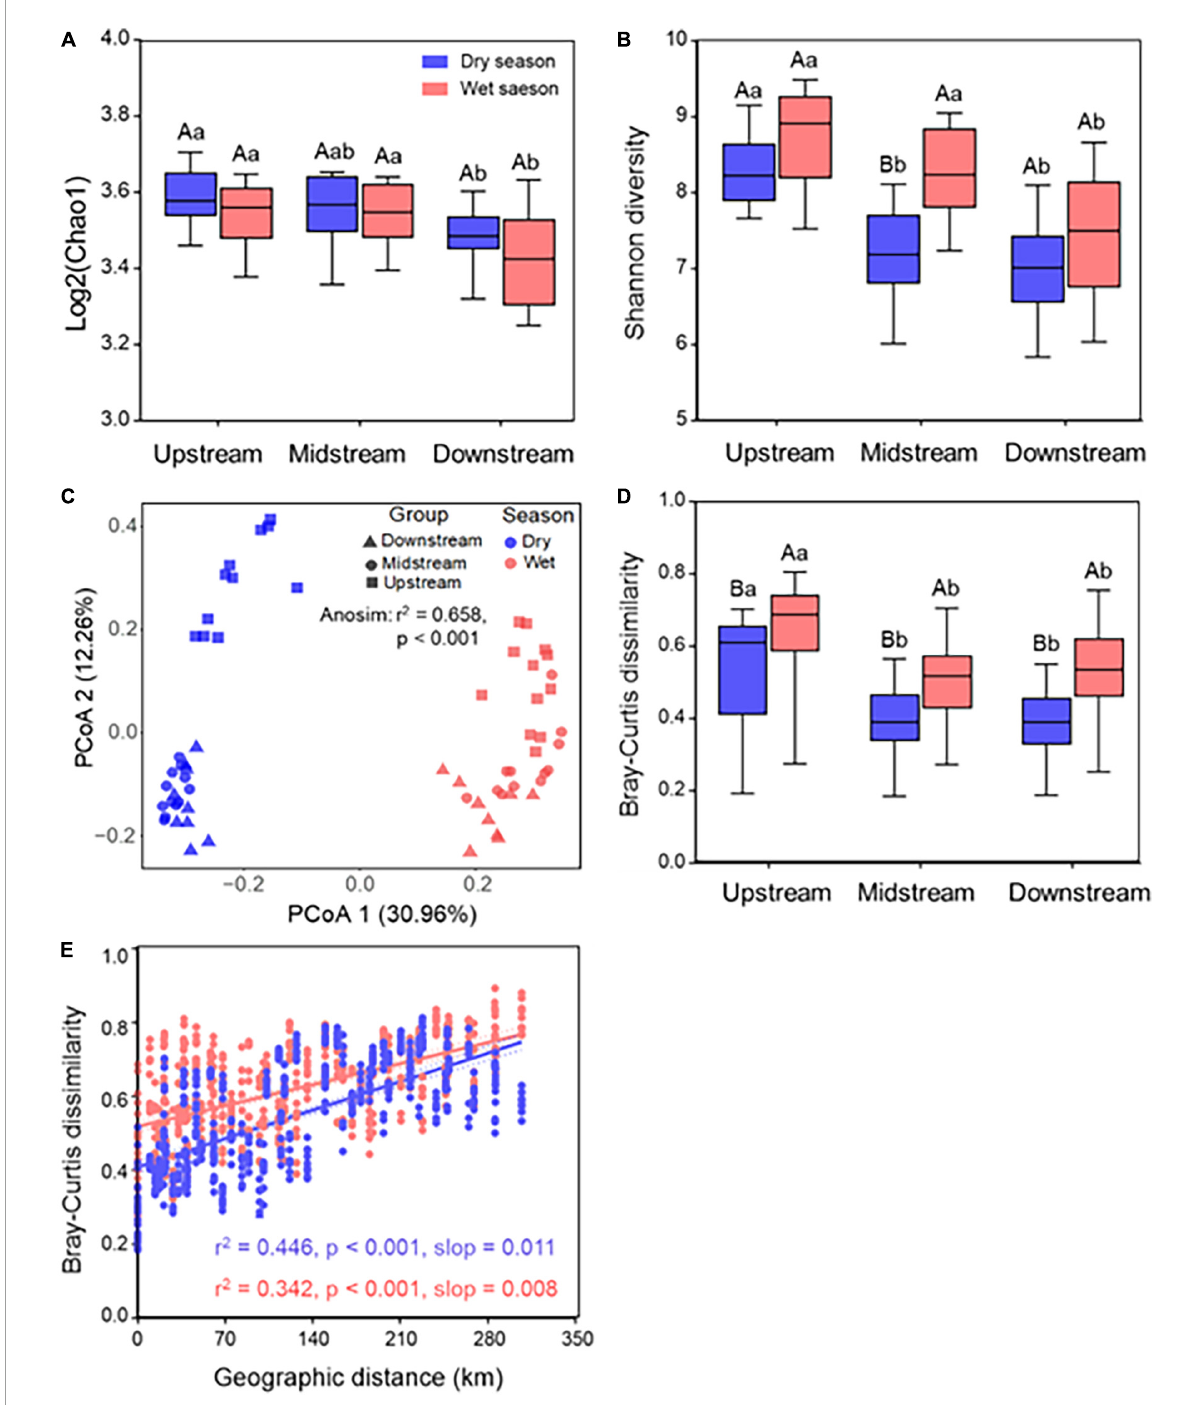
FIGURE1 Bacterial biodiversity and distance–decay pattern of the Chishui River water. The Chao1 diversity (A) and Shannon diversity (B) of the Chishui River water between the dry and wet season along upstream, midstream, and downstream. ANOVA multiple comparisons were used to test the significance along different river sections. (C) Principal coordinated analysis (PCoA) based on Bray–Curtis distance and (D) respective Bray–Curtis dissimilarities; (E) pairwise relationships between Bray–Curtis dissimilarities and geographic distances for both in the dry and wet season samples, solid lines show linear regressions and dotted lines show 95% confidence interval of regression lines. Spearman’s rank correlations were calculated. The p -value was calculated by comparing the observed F -value with those from 1,000 randomized datasets. Different capital letters mean a statistical significance ( p < 0.05) between dry and wet seasons within the same river section, and different small letters mean a statistical significance ( p < 0.05) along different river sections within the same